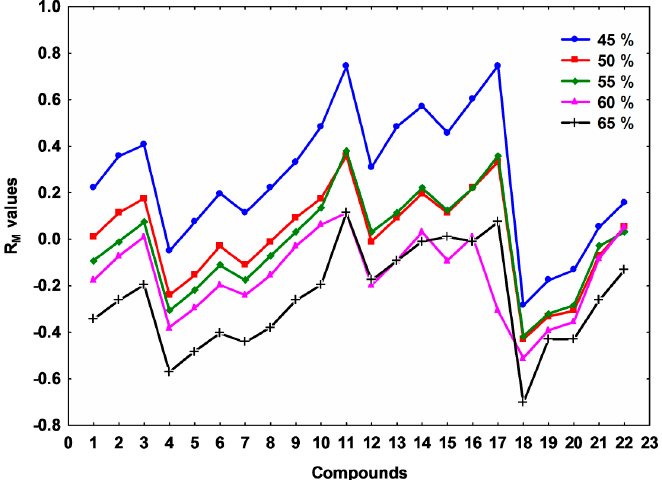
Figure 2. Profiles of R M values at all mobile binary phase composition (% of organic modifier) for all studied compounds. Table 1. Retention parameters obtained from equation R M = R M0 + bC. Group